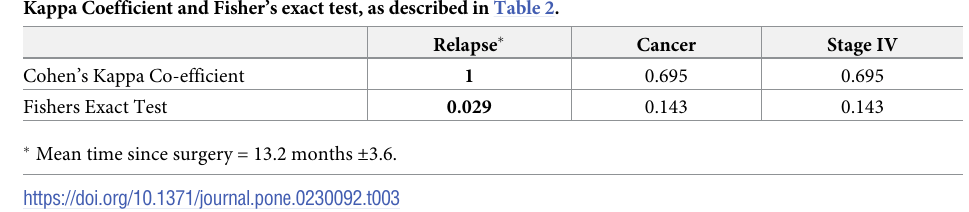
The presence of LVs showing high inflammation significantly correlated with patient relapse ( κ = 0.783, p = 0.03) (Table 3). The presence of medium or high inflammation within LVs showed a moderate agreement with patient relapse ( κ = 0.615, p = 0.07) and patients with Stage IV, relapse and cancer-cell infiltration ( κ = 0.615, p = 0.07) (Table 2). The presence of highly